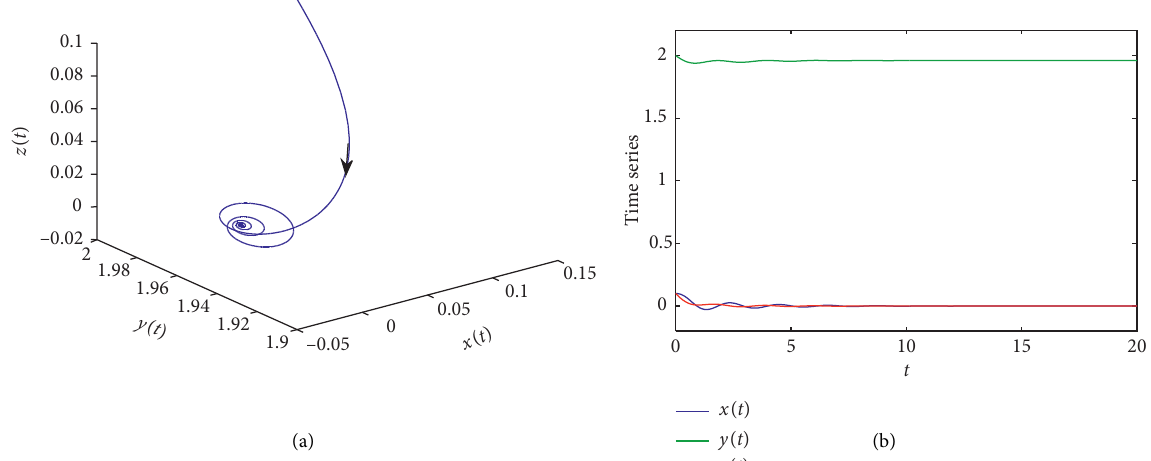
Figure 3: Phase diagram (a) and time sequence diagram (b) of system (3a)–(3c) with initial value ( 0 . 1 , 2 , 0 . 1 ) for τ � 0 . 1 < τ 0 τ . 2 2